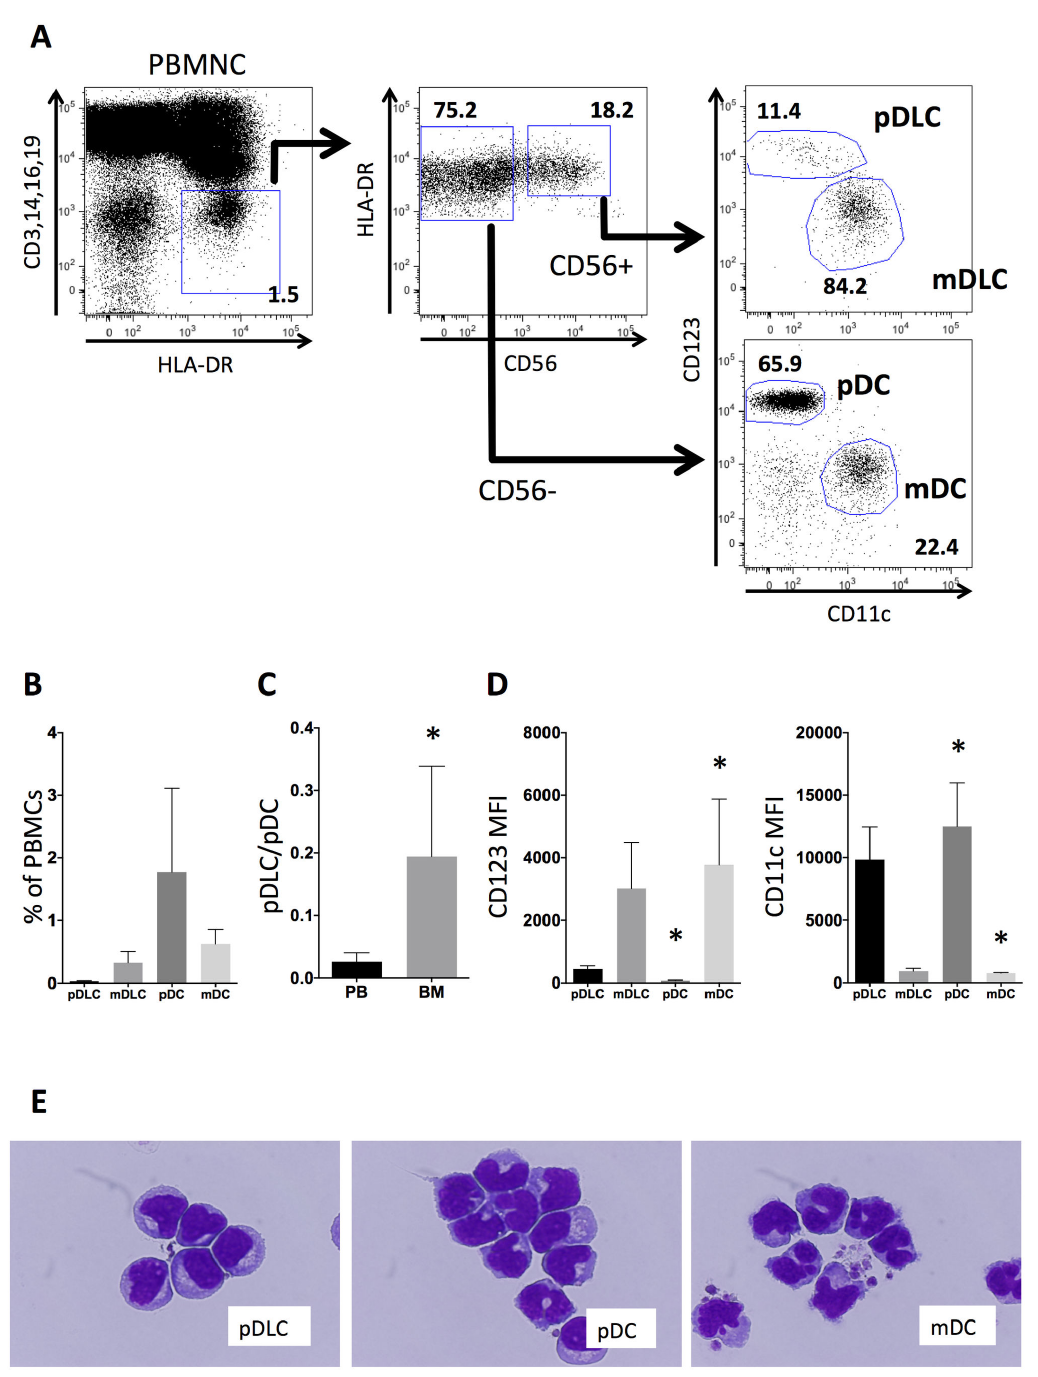
Figure 1. pDLCs are a rare DC population that are morphologically similar to pDCs. (A) PBMNCs were analyzed using flow cytometry. The gated Lin - HLA−DR + population (left) was divided according to CD56 expression (middle), and these two subpopulations were analyzed according to CD123 and CD11c expression to define pDLCs, mDLCs, pDCs, and mDCs (right). The results of one representative experiment are presented. (B) The frequency of pDLC, mDLCs, pDCs, and mDCs in PBMCs (n = 5). pDLCs comprised a very small (0.03%) proportion in PBMCs. (C) The pDLC to pDC ratio was compared between peripheral blood (PB) and bone marrow (BM) cells (n=5). *P < 0.05 compared to PB. (D) MFI of CD123 (left panel) and CD11c (right panel) expression was measured on pDLCs, pDCs, and mDCs in PBMCs (n = 5). *P < 0.05 compared to pDLC. (E) Sorted cells were stained with May–Giemsa solution and observed by light microscopy at 1000× magnification. doi: 10.1371/journal.pone.0081722.g001 PLOS ONE |